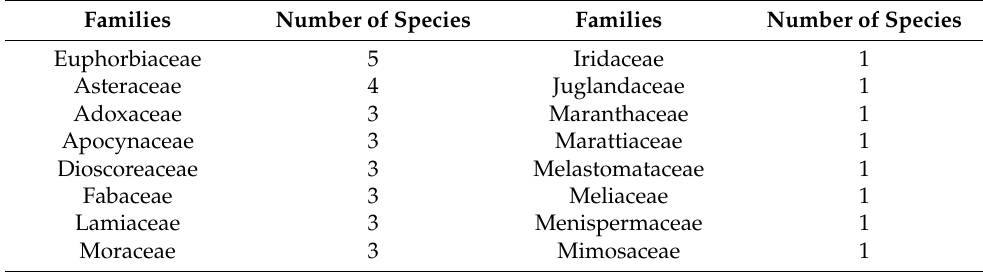
Figure 2. Some diverse medicinal plants from the “People-Forest-Miang” communities of Mae Kam- pong Village: ( a ) Albizia myriophylla Benth.; ( b ) Angiopteris evecta (G. Forst.) Hoffm.; ( c ) Averrhoa carambola L.; ( d ) Baliospermum calycinum Müll. Arg.; ( e ) Cyanthillium cinereum (L.) H.Rob.; ( f ) Erythrina stricta Roxb.; ( g ) Ficus hirta Vahl; ( h ) Morinda angustifolia Roxb. var. angustifolia ; ( i ) Mussaenda sanderi- ana Ridl.; ( j ) Phlogacanthus curviflorus (Wall.) Nees; ( k ) Picrasma javanica Blume; ( l ) Pittosporopsis kerrii Craib; ( m ) Sambucus javanica Reinw. ex Blume subsp. javanica ; ( n ) Solanum torvum Sw.; ( o ) Toddalia asiatica (L.) Lam. Table 1. Distribution of medicinal plant species in the Cha Miang forest of Mae Kampong Village.